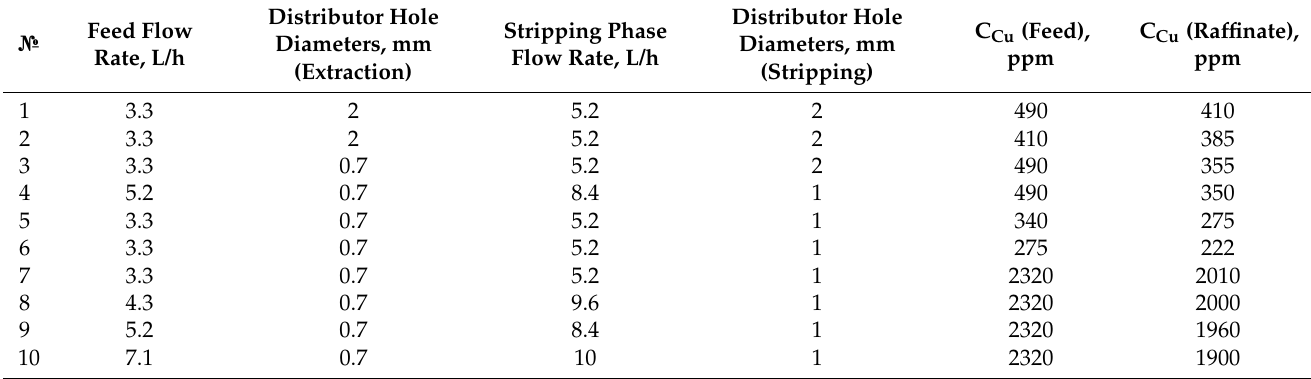
Table 2. Results and conditions of experiments conducted in the small apparatus.